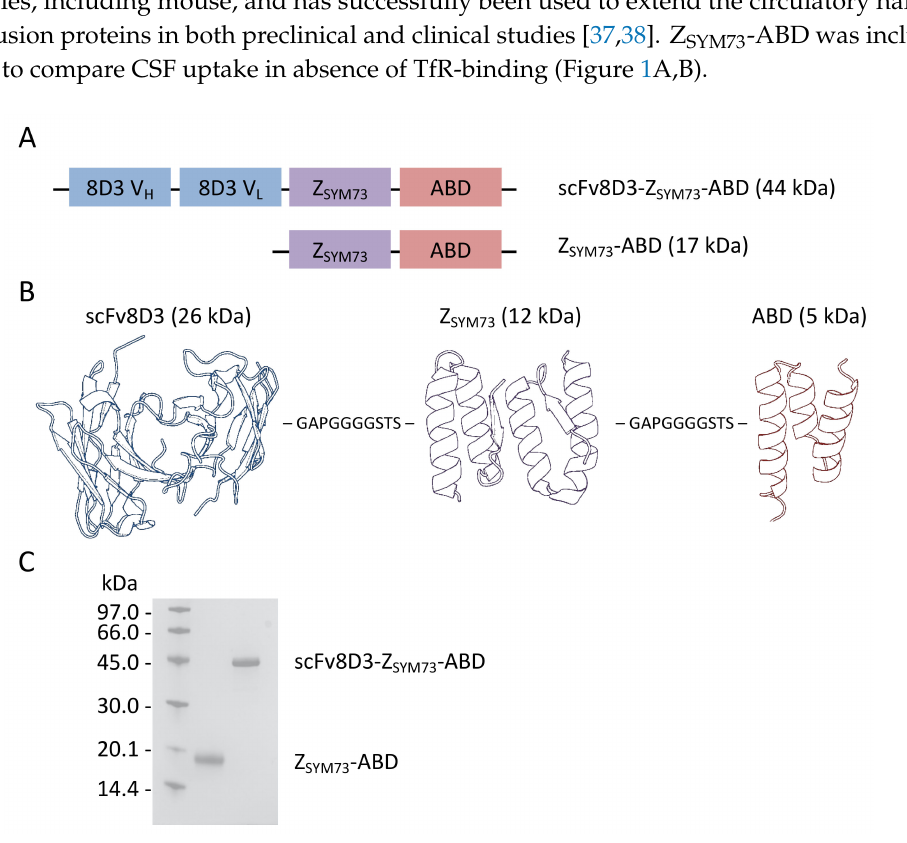
Figure 1. ( A ) Schematic representation of the tri-specific scFv8D3-Z SYM73 -ABD and the control protein Z SYM73 -ABD. Abbreviations scFv = single-chain variable fragment, Z = a ffi body, ABD = albumin-binding domain. ( B ) Schematic picture over the structure of scFv8D3-Z SYM73 -ABD with linkers between the subunits as amino acid sequences. The schematic structure is composed of following PDB IDs: scFv: 1KTR Zsym: 2OTK and ABD: 1GJT. ( C ) SDS-PAGE analysis of